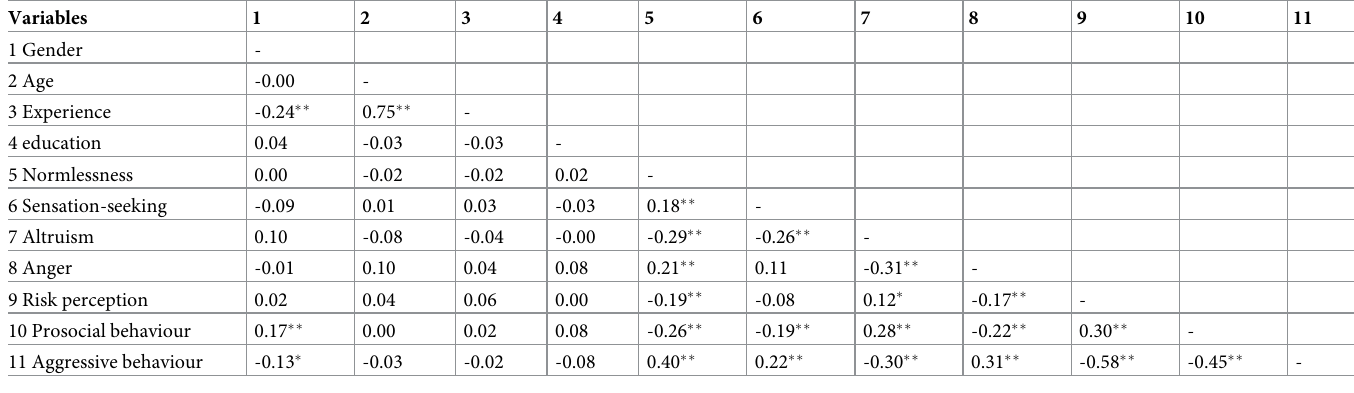
Table 3. Correlations between risk perception, personality traits and driving behaviours.